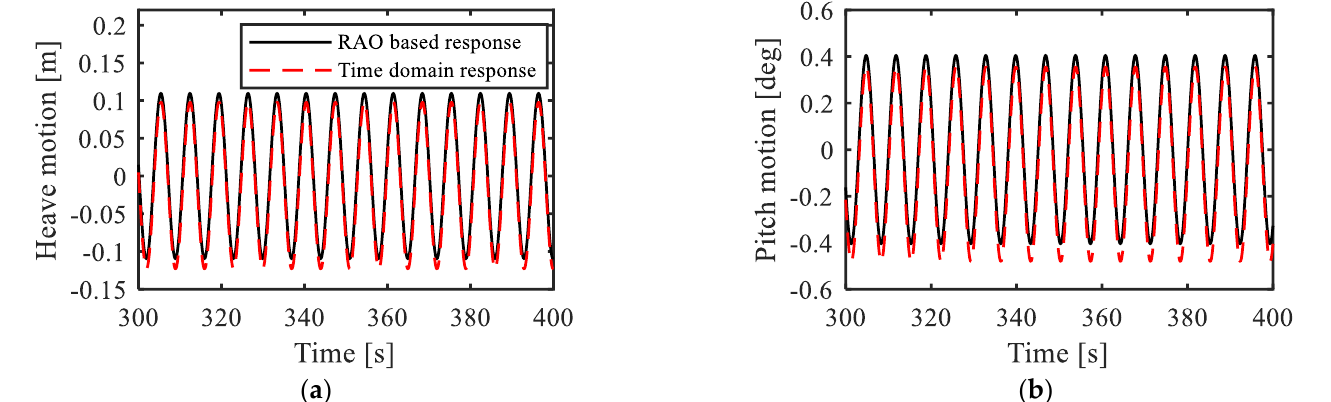
Figure 7. Comparison of the time-domain motions and the RAO-based responses. ( a ) Comparison of the heave motions; ( b ) Comparison of the pitch motions.